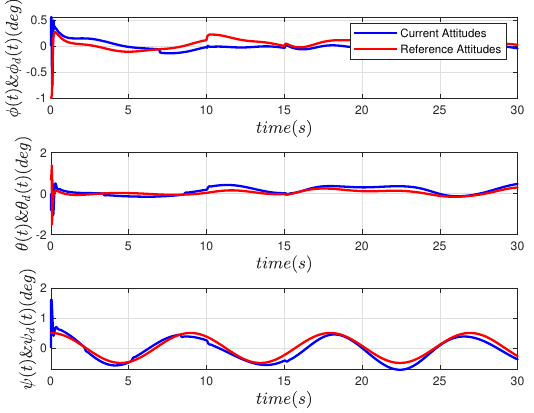
Figure 9. UAV’s Attitude Tracking Performance: SM.